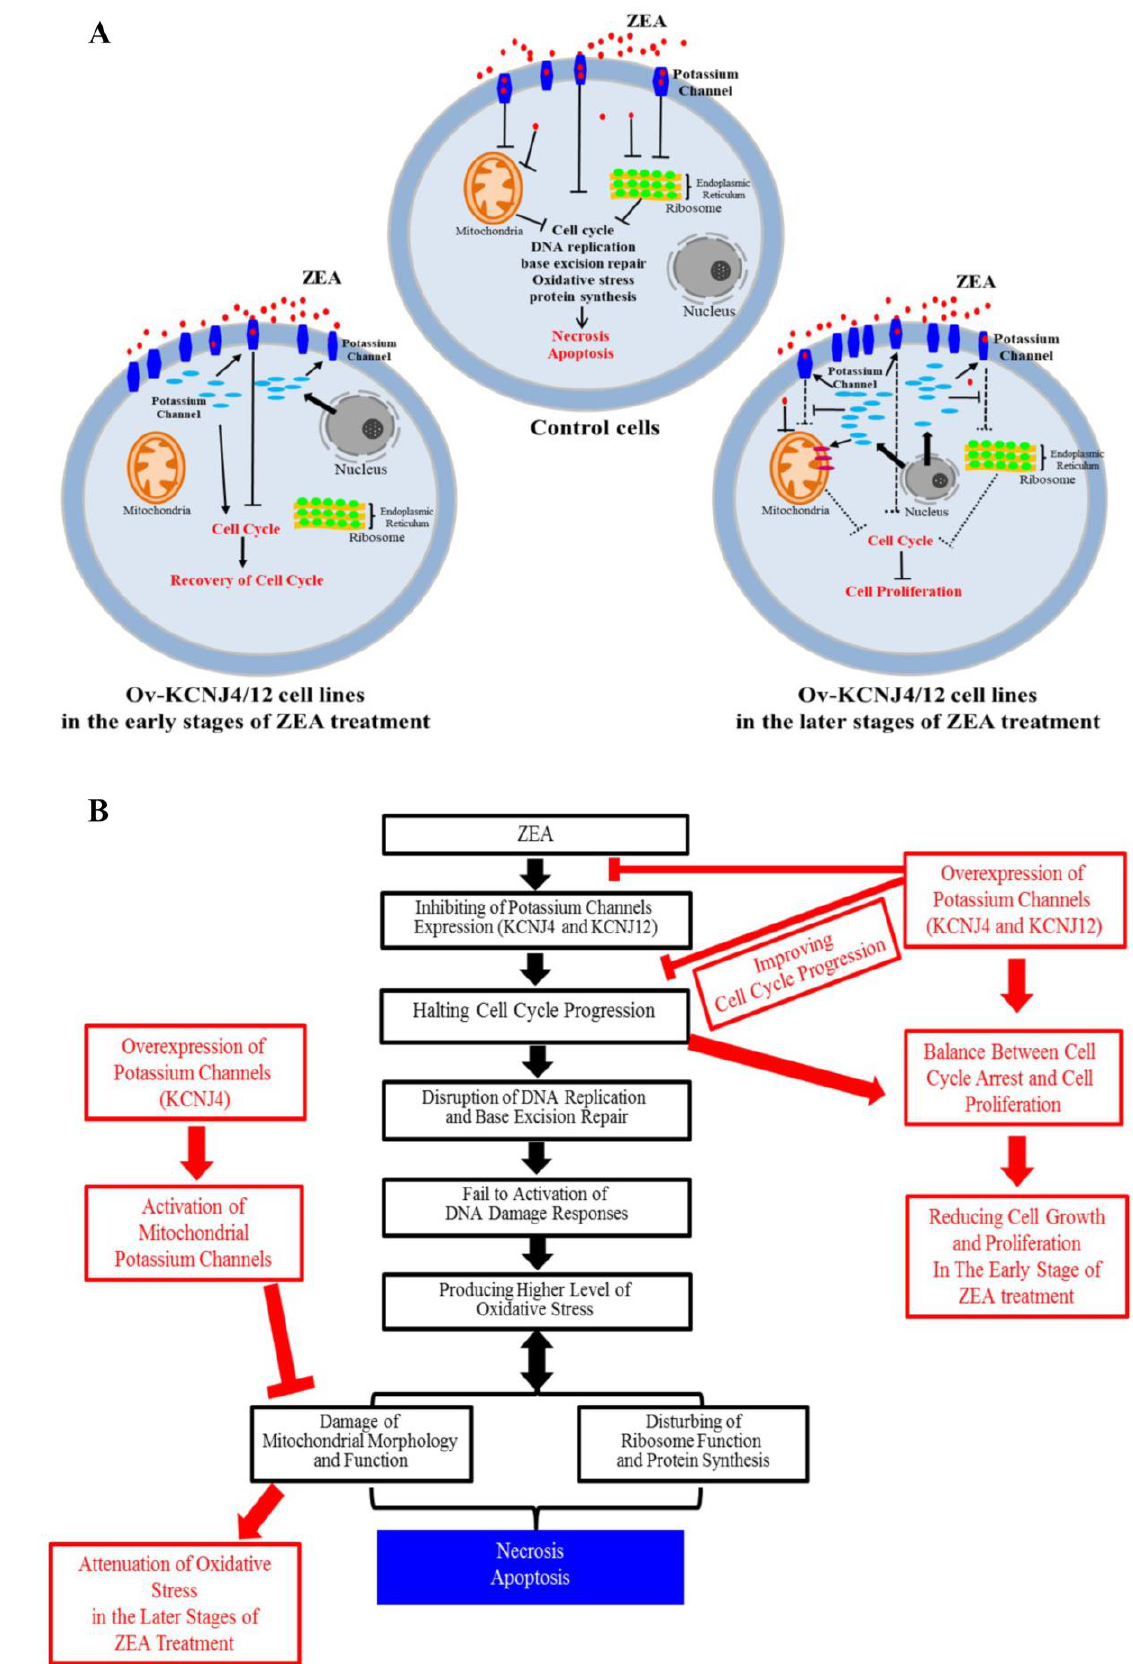
FIGURE 6: Model depicting the interaction between potassium channel genes and ZEA toxin. (A, B) Model depicting how the potassium channel genes control for mycotoxin-induced cell death the reacted with ZEA